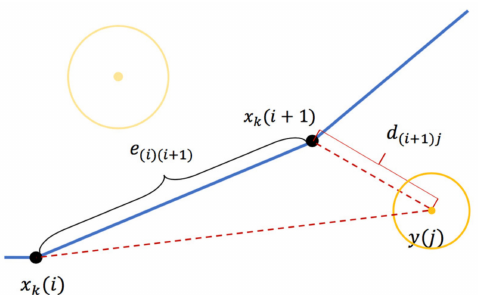
Figure 8. Illustrating graphics of the shortest distance ( d ij ) being a distance from a visited cell tower location y(j) to the nearest waypoint ( x k (i + 1) in this case) along the edge e (i)(i + 1) .